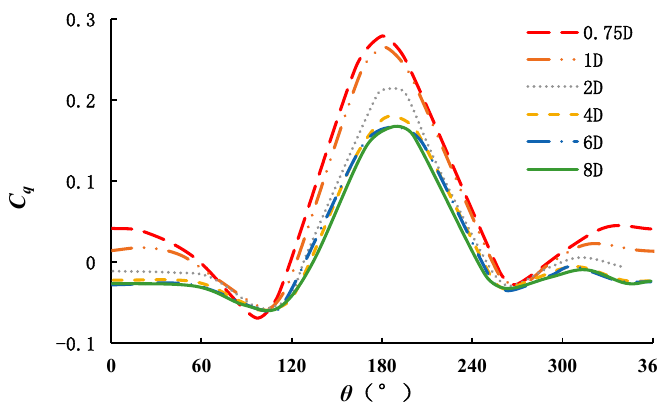
Figure 9. Variation trend of torque coefficient of single turbine with phase angle and varying D w for non-slip wall.